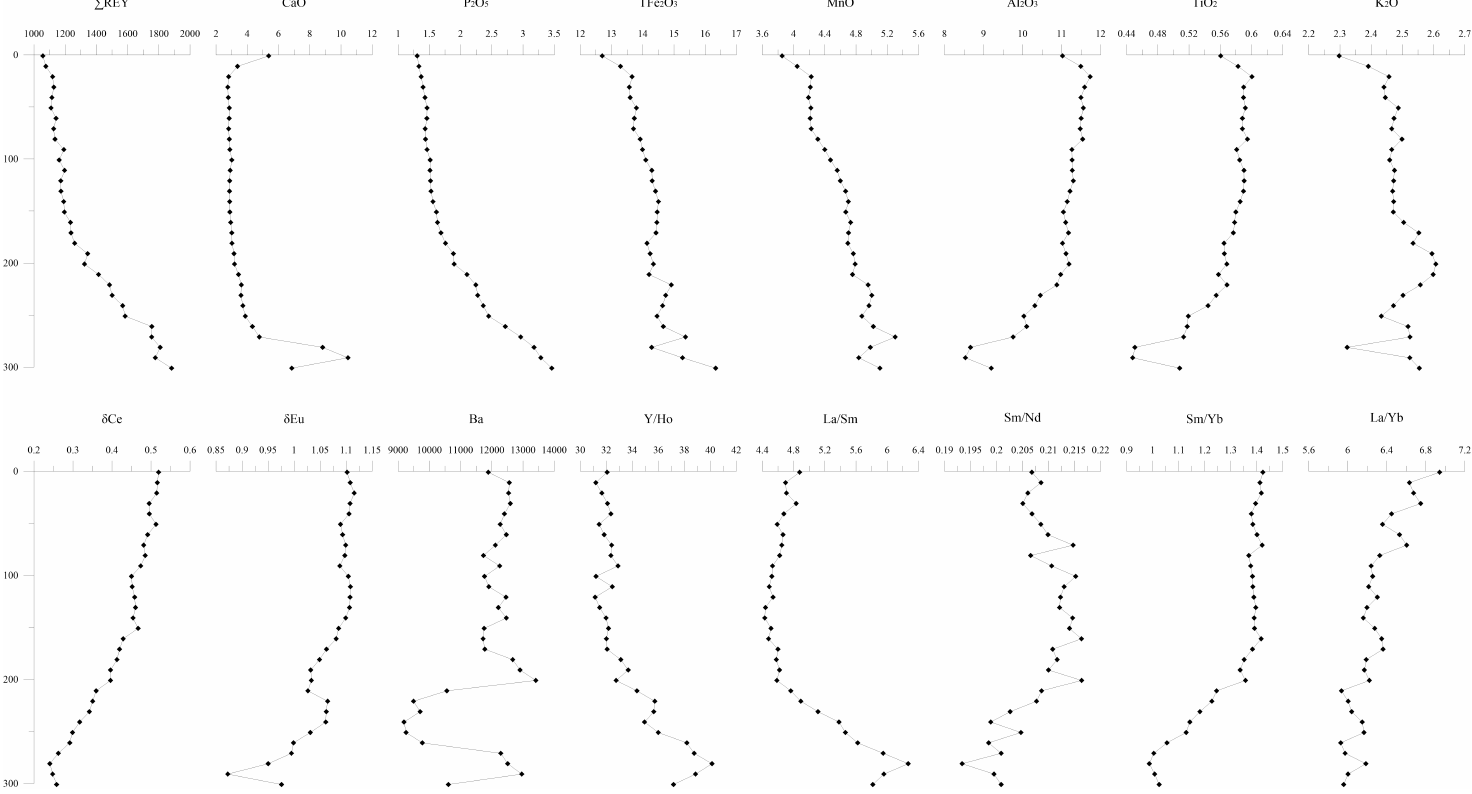
Figure 5. Profiles of REY content and other characteristic parameters of the bulk sediment samples from core S021GC17.